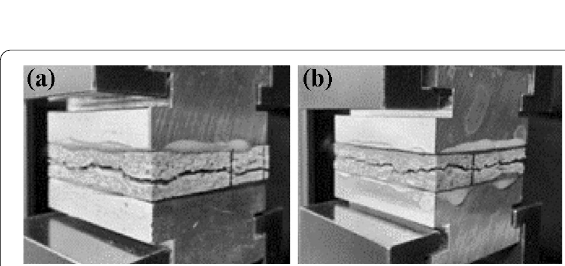
Fig. 6 Failure positions of two randomly selected IB specimens. a Randomly selected No. 35 specimen A. b Randomly selected No. 86 specimen